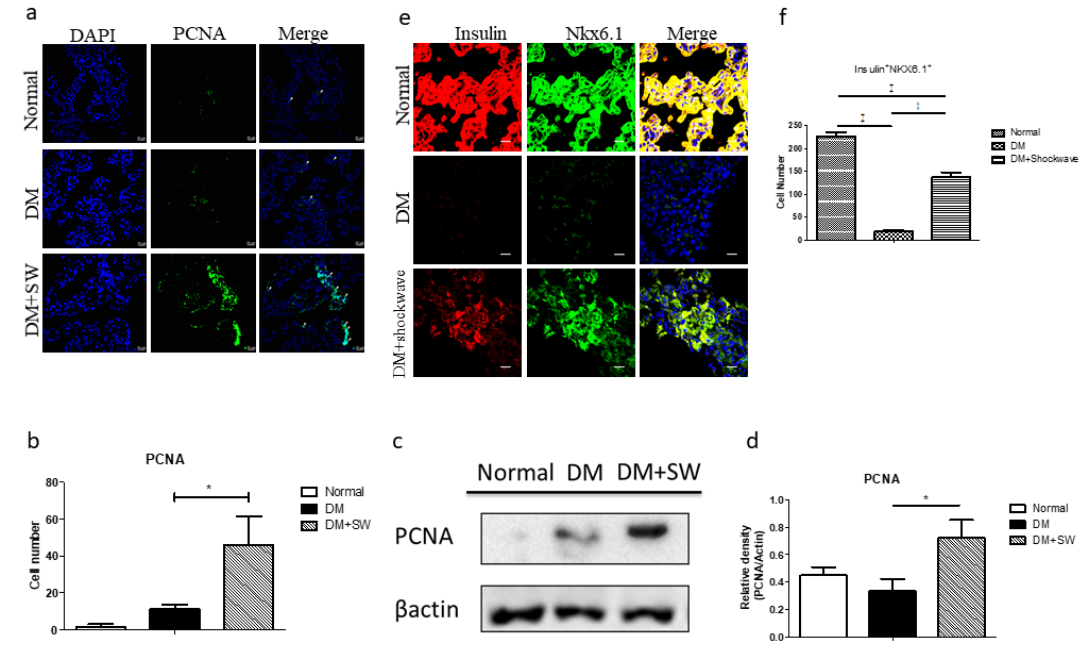
Figure 3. Low-energy SW significantly enhanced proliferation and beta cells regeneration. ( a , b ) Representative images of pancreatic tissue IF stained with PCNA indicating cell proliferation, and quantification of IF staining by image analysis. Scale bar = 20 µ m; ( c , d ) Western blot analysis PCNA expression in pancreatic tissue and quantification of Western blot by densitometric analysis; ( e , f ) Representative images of pancreatic tissue IF stained with Insulin (red), Nkx6.1 (green) indicating pancreatic beta cells number and quantification of IF staining by image analysis. Scale bar = 20 µ m. * p < 0.05, ‡ p < 0.001 ( n = 6–10).